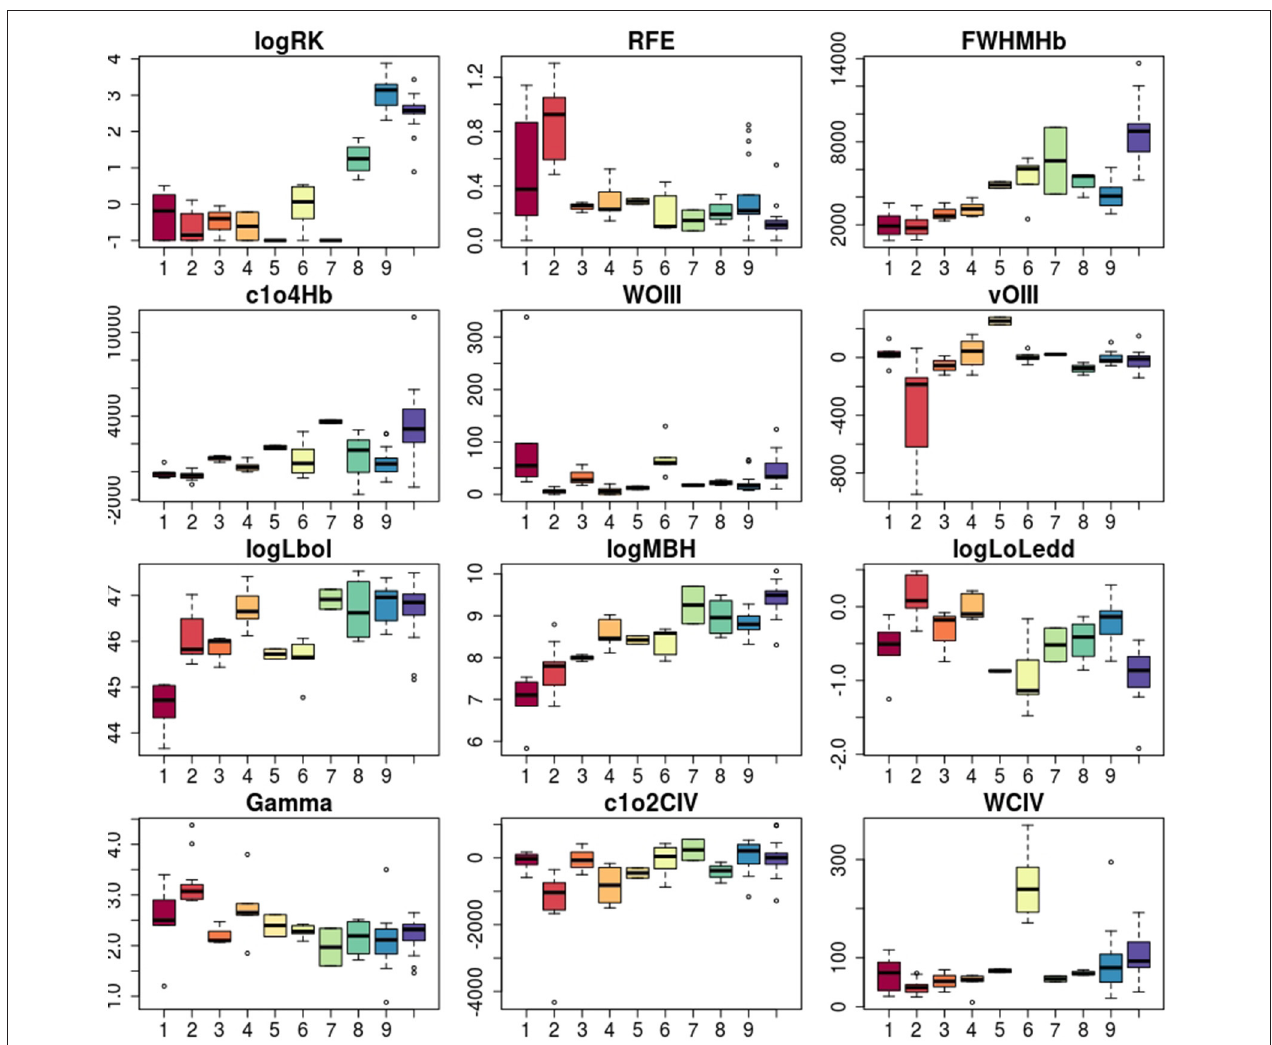
FIGURE 2 | Boxplots for the groups in the 85 quasar sample as defined on the tree in Figure 1 . The parameters shown are: the radio loudness parameter (RK), the intensity ratio between Fe λ 4570 and H β (RFE), the Full Width at Half-intensity Maximum (FWHMHb) and the line centroid displacement at quarter maximum (c1o4Hb) of the H β line, the equivalent width (WOIII) and the peak shift (vOIII) of the [OIII] λ 5007 line, the bolometric luminosity (Lbol), the Black Hole Mass (MBH), the Eddington ratio L/L edd (LoLedd), the soft X-ray photon index (Gamma), the centroid displacement at half maximum (c1o2CIV) and the equivalent width of the CIV λ 1549 line